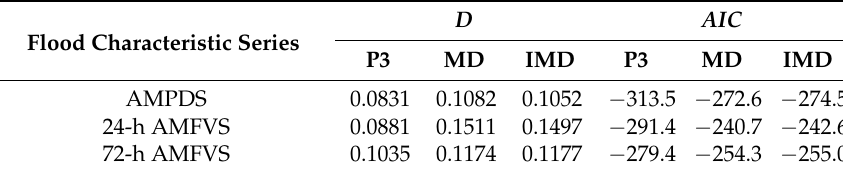
Table 12. Goodness-of-fit test results for the MD and IMD methods. Flood Characteristic Series